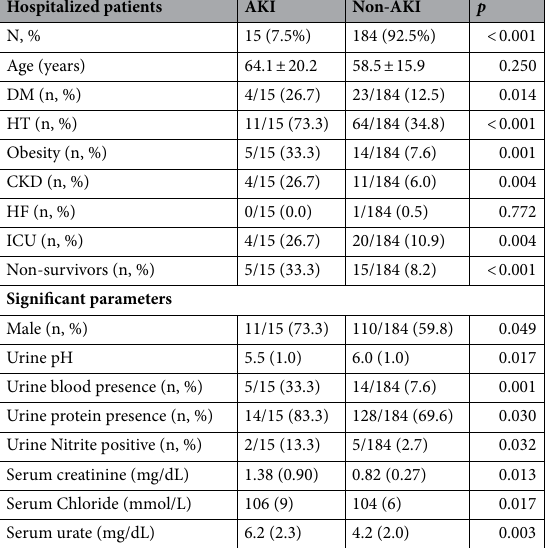
Table 3. Clinical data and biochemical results for AKI and non-AKI COVID-19 patients. Quantitative variables were described by mean ± standard deviation or median (IQR); AKI, Acute Kidney Injury; DM, Diabetes; HT, Hypertension; CKD, Chronic kidney disease; HF, heart failure; ICU, Intensive Care